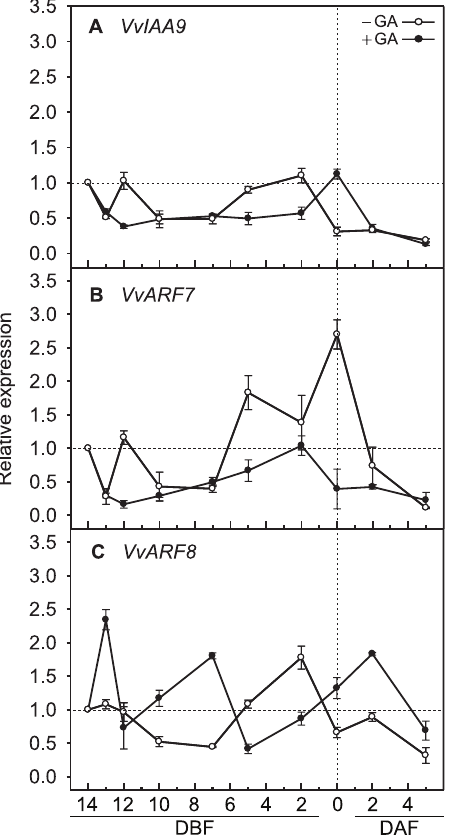
Figure 2. Transcriptional changes in Vitis negative regulator genes for fruit set initiation. ( A ) VvIAA9 , ( B ) VvARF7 , and ( C ) VvARF8 in grapevine inflorescences with and without GA application. DAF, days after full bloom; DBF, days before full bloom. Quantitative reverse transcription-PCR was performed to measure the expression level of each gene using the comparative C T method. After normalization of each sample to the expression of the internal control VvActin1 , the expression of each gene relative to the 14 DBF sample was calculated. Bars are standard errors of the means from three independent